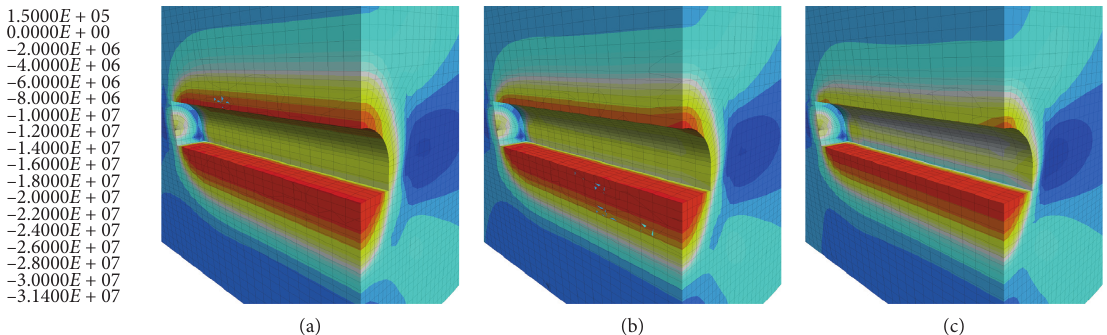
Figure 14: ZZ-stress. (a) Unsupported. (b) Primary support. (c) Secondary support.